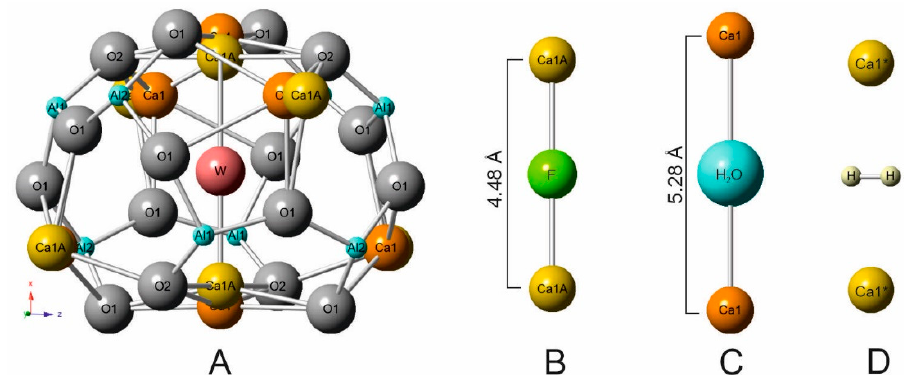
Figure 3. ( A ) W site is at the cage centrum in fluorkyuygenite [1]. ( B ) Geometry of linear group Ca-F-Ca. ( C ) Geometry of Ca-H 2 O-Ca. ( D ) Possible position of H 2 molecule stabilized by Ca1* shift towards the cage centrum.